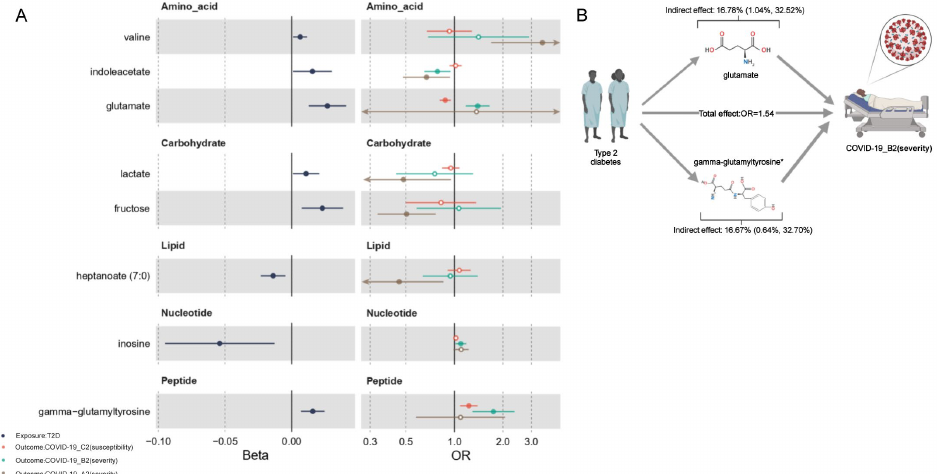
Figure 3. ( A ) Forest plots of 8 T2D-affected human serum metabolites. Left panel: causal effects of genetically predicted BMI on the serum levels of metabolites. Beta (x-axis) was the log10 unit changes of metabolite level per one-standard-deviation (1 SD) increase in T2D (T2D as exposure). Right panel: causal effects of the 8 T2D-affected metabolites on the COVID-19 phenotypes. OR (x-axis) was the estimated odds ratio of the outcome per 1 log10 unit increase in the serum levels of metabolites. Solid dots indicate significant associations (P IVW < 0.05). ( B ) Diagrams illustrating the mediation effects of mediators on the causal path from T2D to COVID-19 phenotypes A2 (red), B2 (red), and C2 (yellow). *: Indicator of statistical significance of multivariable Mendelian randomization (MVMR) analysis for causal associations between mediators and Metabolites 2022 , 12 , x FOR PEER REVIEW COVID-19 phenotypes conditioning on genetically predicted T2D risk.